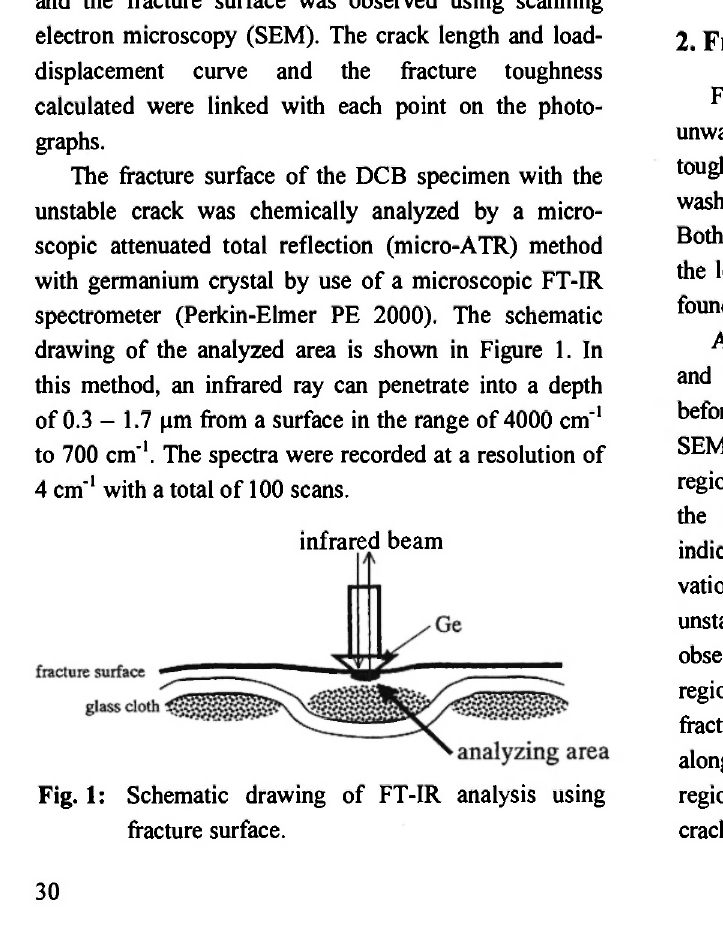
Fig. 1: Schematic drawing of FT-IR analysis using fracture